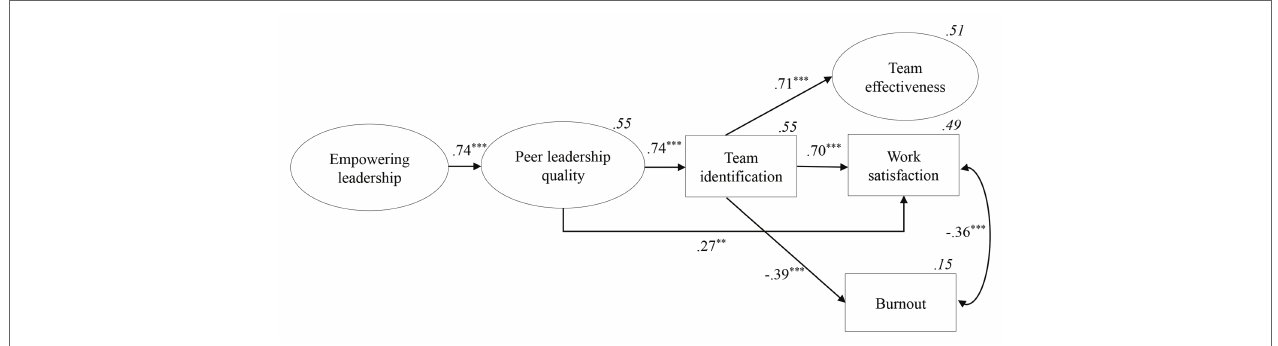
FIGURE 2 | Structural model, representing the influence of empowering on peer leadership quality, with the latter in turn influencing (a) team effectiveness via full mediation of team identification, (b) burnout via the same full mediation of team identification, and (c) work satisfaction directly and indirectly via a partial mediation of team identification. Two covariations were included in the model: one between two subscales of team effectiveness (i.e., interpersonal and value effectiveness) and one between work satisfaction and burnout. Standardized regression coefficients are shown along each path as well as the proportions of explained variance (in italics). * p < 0.05; ** p < 0.01; *** p <